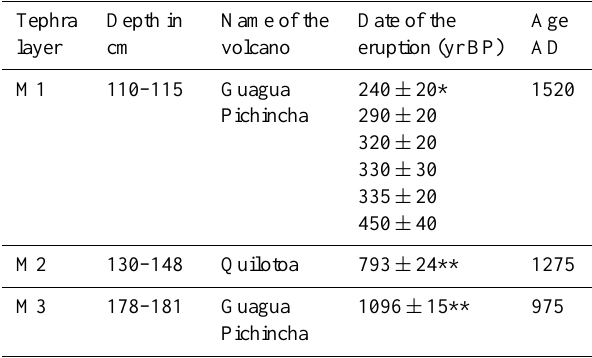
Table 2. Chronology of core PA 1-08 from tephra analyses. The age AD of the eruptions was obtained from the Bacon age model (Fig. 3) after plotting all the published radiocarbon dates (Mothes and Hall, 2008; Robin et al.,